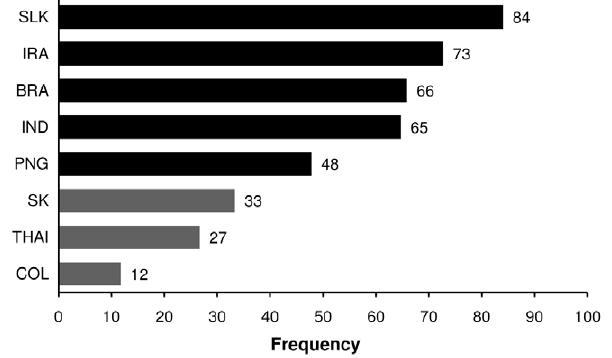
Figure 2. Frequency of the seven nsSNP haplotypes of DBP II that cover at least fifty percent of DBP II sequences deposited in GenBank. Coverage of the selected haplotypes in each country: countries that at least 50% of parasites are covered by the selected haplotypes are represented by black bars and countries that less than 50% of the parasites are covered by the selected haplotypes are represented by grey bars. The selected haplotypes were: 4, 12, 23, 24, 44, 59, 64 (for haplotype sequences see Table S2).